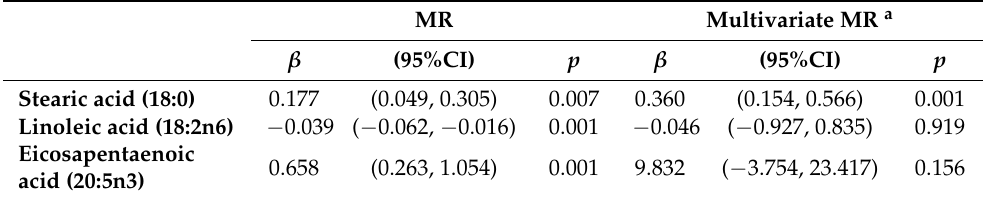
Table 4. Sensitivity analysis: MR results of the fatty acids and frailty index using the proxy